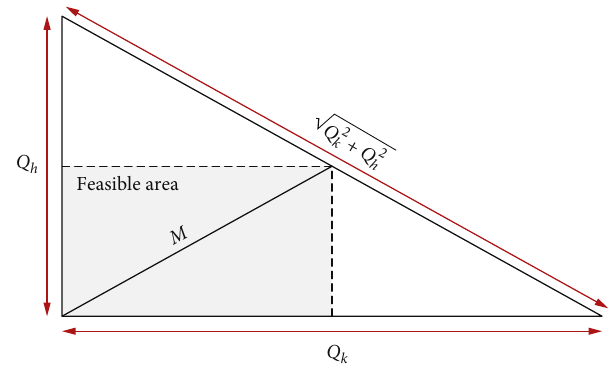
ffiffiffiffiffiffiffiffiffiffiffiffiffiffiffiffi q Q 2 + Q 2 Þ /2 : k h